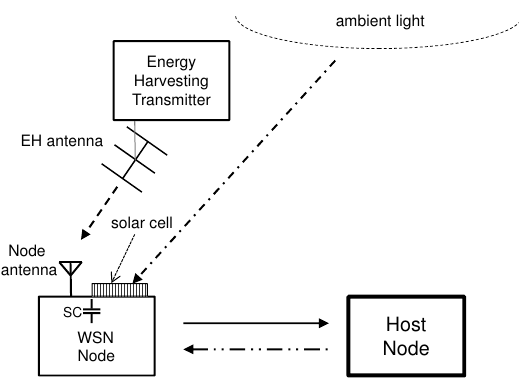
Figure 1. RF energy harvesting link (- - -) and photoenergy harvesting link (- . - . -) between energy sources and WSN node harvesting systems are illustrated. Link between WSN node and Host node (—) and return link between Host node and WSN node (- .. - .. -) are viewed along with supercapacitor